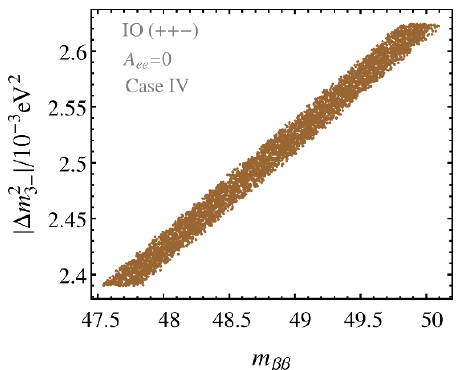
(cid:12) (cid:12) j = (cid:12) m 2 3 (cid:0) ( m 2 1 + m 2 2 ) = 2 (cid:12) and m (cid:12)(cid:12) for CP (cid:22)(cid:28) symmetric 3 (cid:0) ) ee (case IV). The oscillation observables (cid:23)